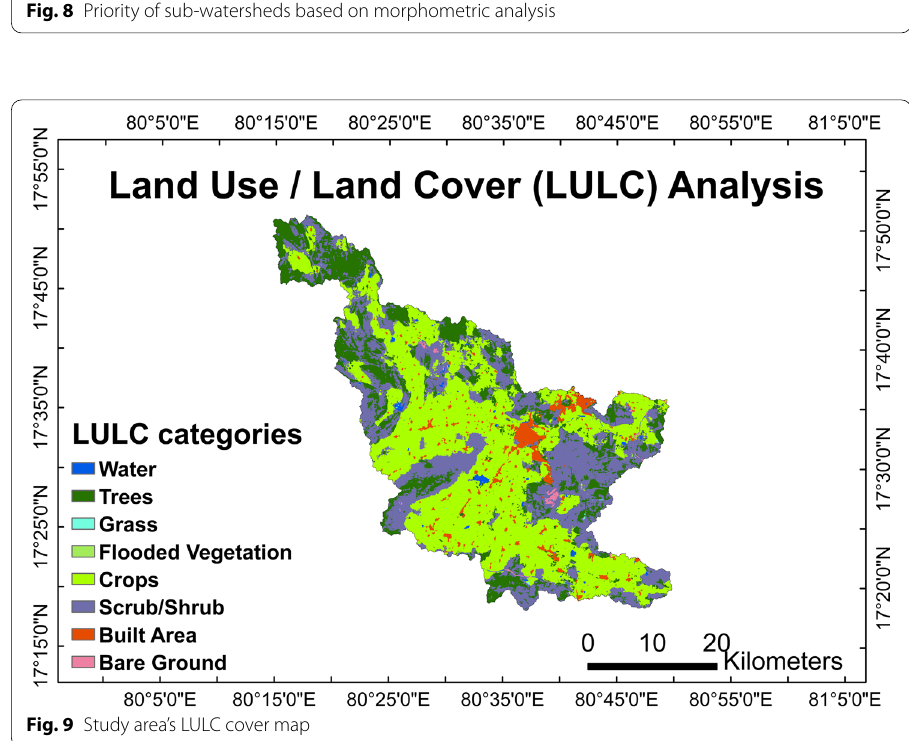
Fig. 9 Study area’s LULC cover